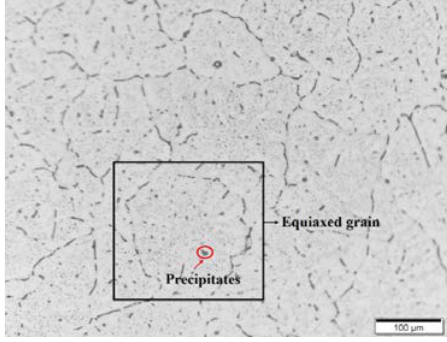
Figure 1. The starting microstructure of the 6A02 aluminum alloy.